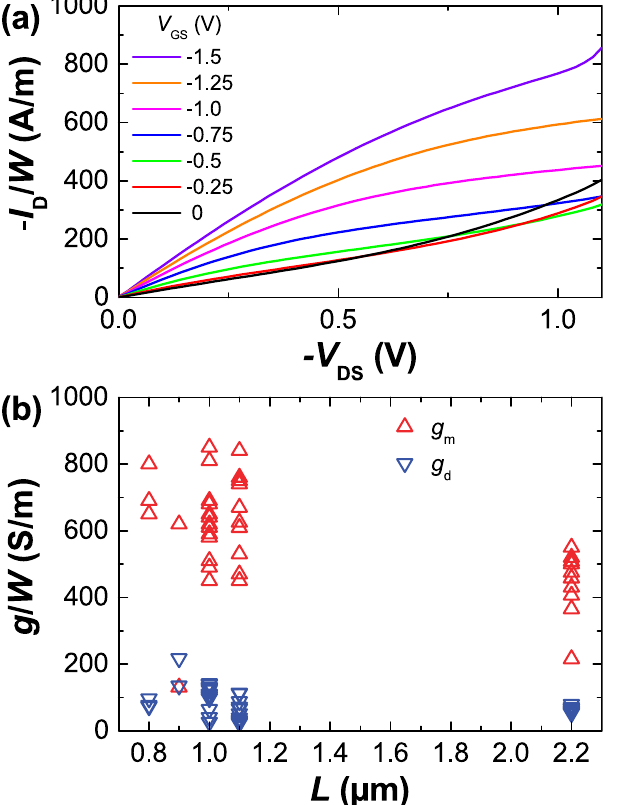
Figure 2. Output characteristics and small-signal conductances of the fabricated GFETs in ambient air. ( a ) Drain current I as a function of V for different V in a GFET with = D DS GS